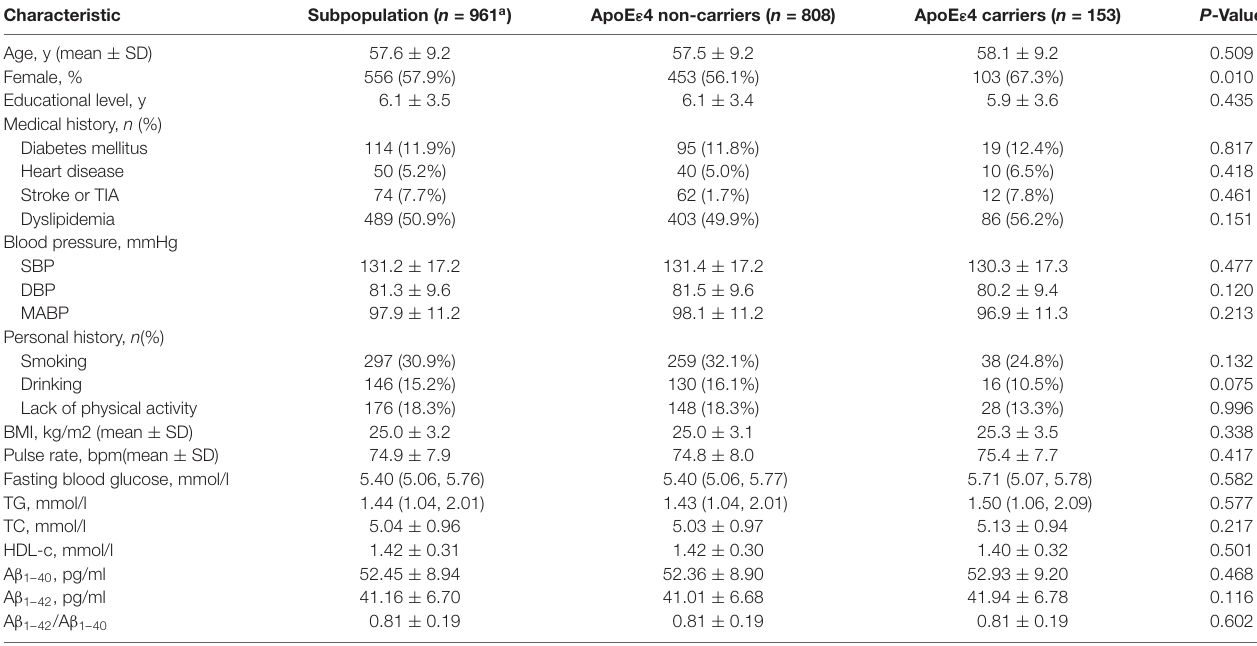
Numbersaremean(SE)orcount(%).Pvaluesobtainedfromttestor χ 2 testorANOVAincomparisonofApoE ε 4non-carriersandApoE ε 4carriers. a Dataavailablefor961participants, 961 participants agreed to perform gene testing. Abbreviations: TIA, transient ischemic attack; BMI, body mass index; TG, triglyceride; TC, total cholesterol; HDL-c, high-density lipoprotein